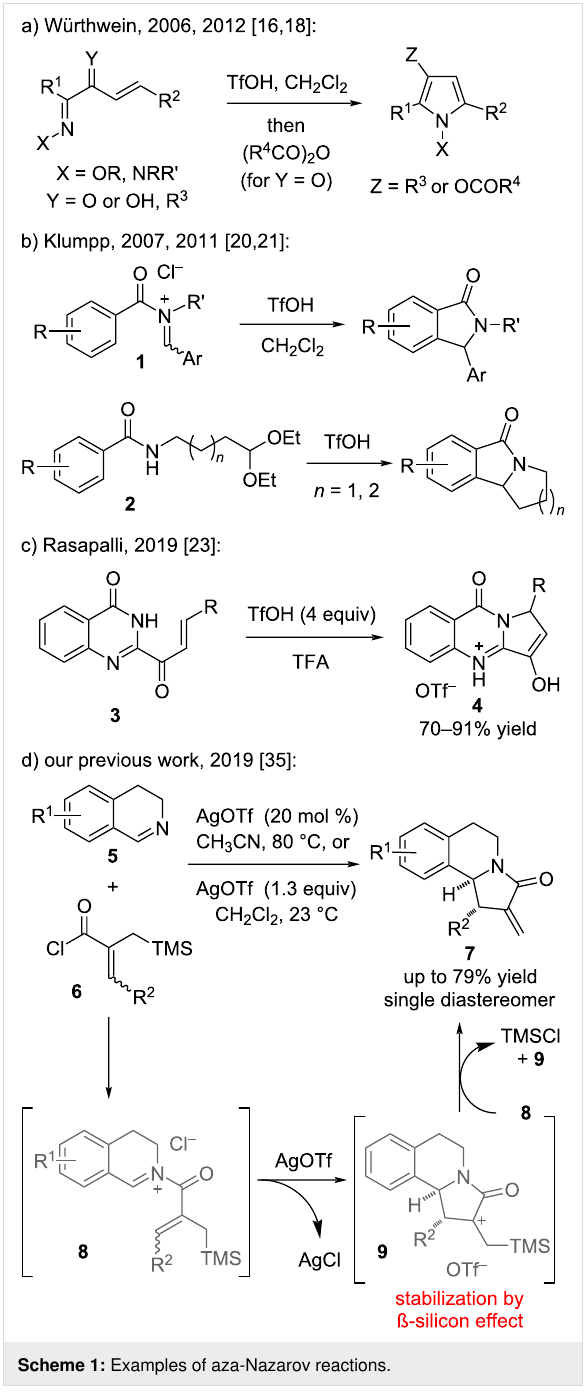
Scheme 1: Examples of aza-Nazarov